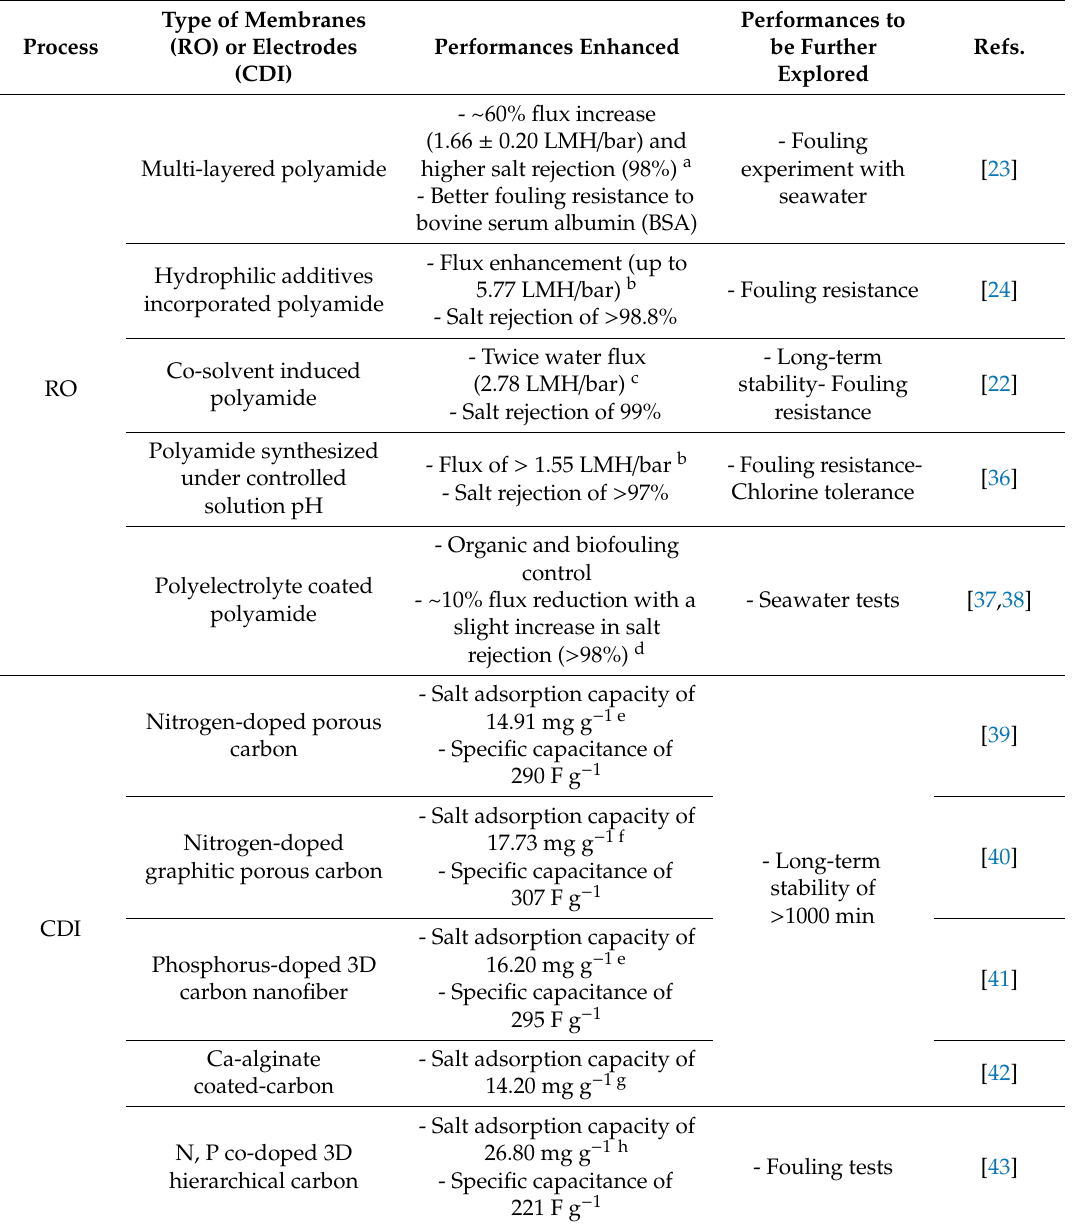
Table 1. A summary of enhanced and unexplored performances of the representative polyamide (RO) or carbon (CDI) materials in water desalination. Water permeance and selectivity of commercial thin-film composite (TFC) RO membrane are ~1 LMH / bar at 99% NaCl rejection [32,33]. The